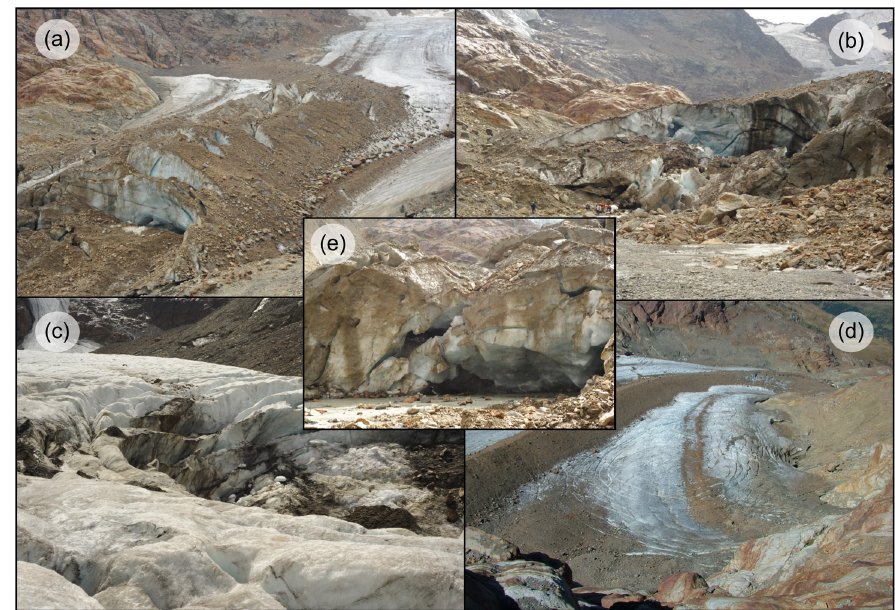
Figure 2. Collapsing areas on the tongue of Forni Glacier: (a) faults cutting across the eastern medial moraine; (b) glacier terminus; (c) near- circular collapsed area on the central tongue; (d) large ring fault on the eastern tongue at the base of the icefall. (e) Close-up of a vertical ice cliff at the glacier terminus. The location of features is reported in Fig. 1. Photos courtesy of G. Cola.